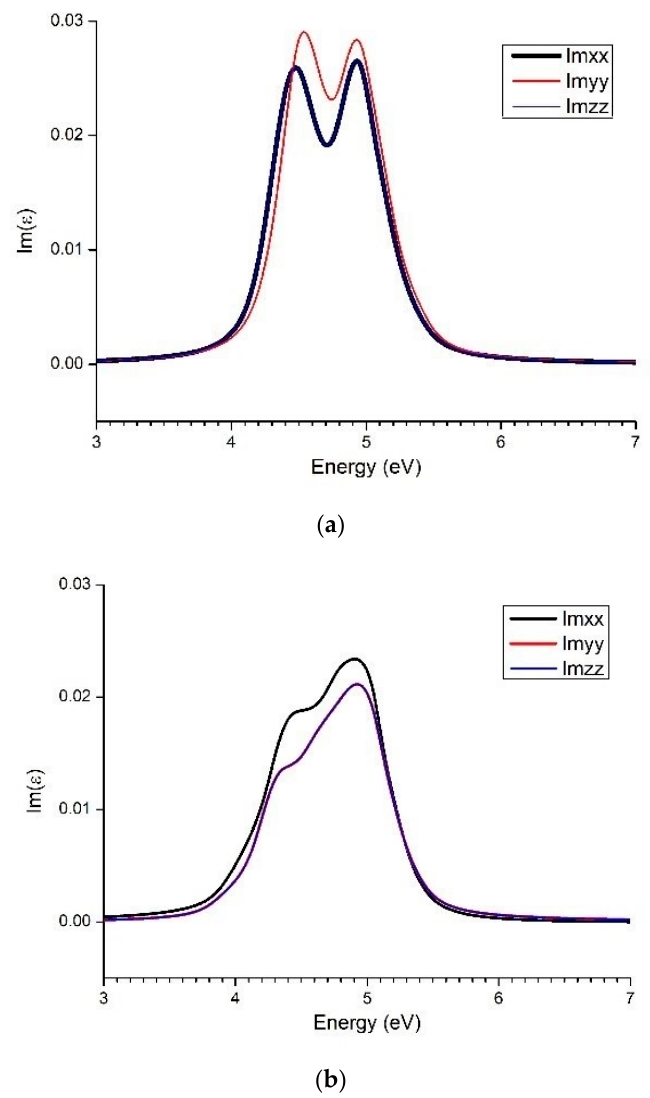
Figure 6. Imaginary part of dielectric function of YAG doped by La ( a ) with 2 atoms ( b ) with 4